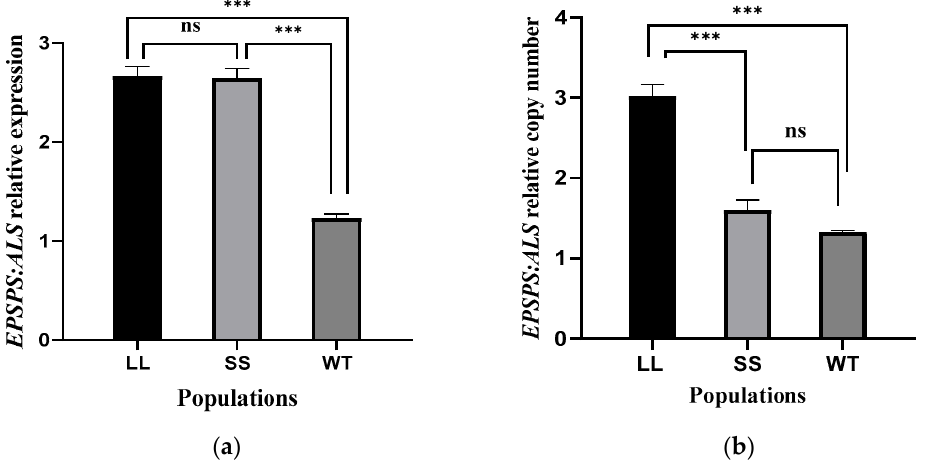
Figure 3. EPSPS gene expression ( a ) and copy number ( b ) relative to acetolactate synthase ( ALS ) in the leaf tissue of three goosegrass populations (LL, SS, WT) without glyphosate treatment. Twenty individuals were selected from each population and vertical bars show the SEM for the replicates. The non-parametric Kruskal-Wallis H test ( p < 0.05) was selected to analyze the data. Asterisks indicate significant differences based on data of expression or copy number among goosegrass populations, and ns indicates no significant differences.